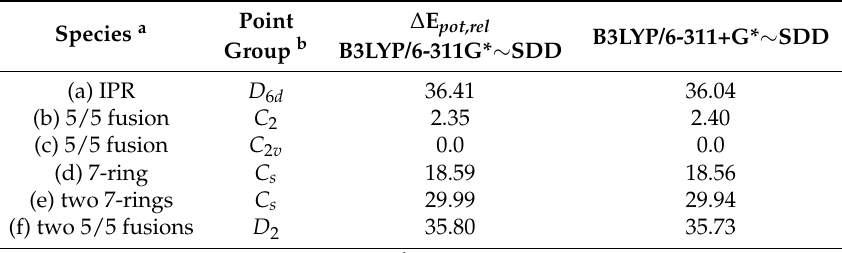
Table 1. Eu@C 72 relative potential energies ∆ E pot , rel [kcal/mol]. Species a